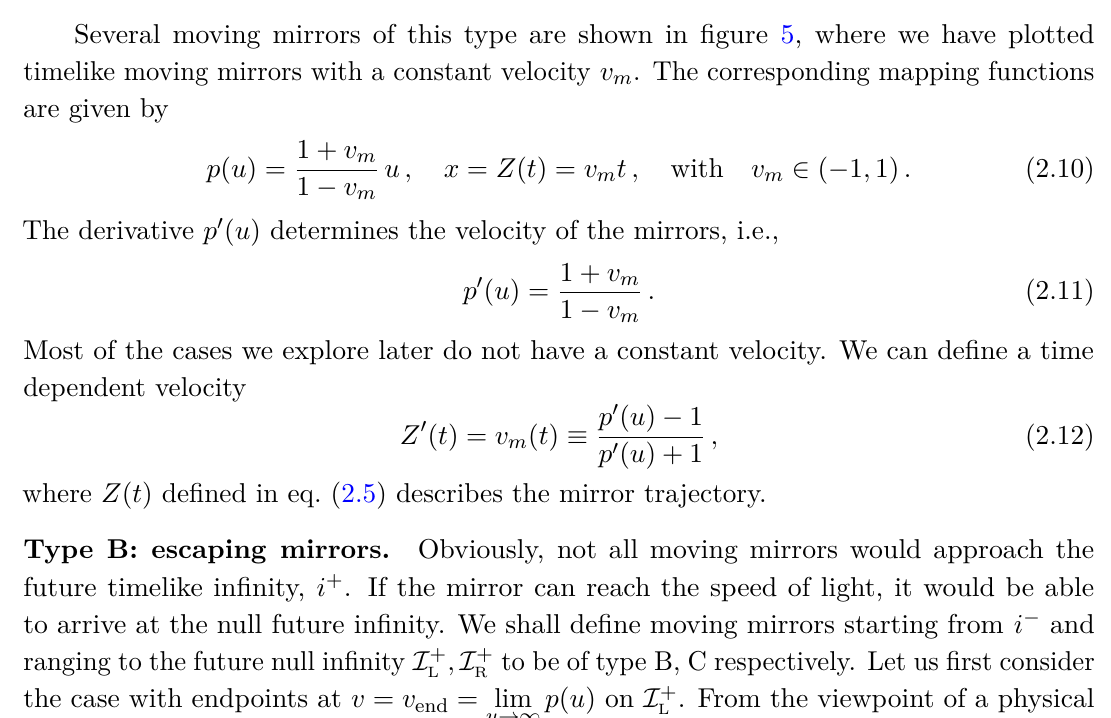
Figure 6 . Type B mirrors with v end = 0 . The three types B + , B 0 and B − are classified in table 2. Left: different conformal mapping functions p ( u ) as defined in eq. (2.18) with fixing β = 1 = u B and taking n = 2 , 1 , 1 , see also table 2. Right: the corresponding trajectories of moving mirrors 2 shown in a Penrose